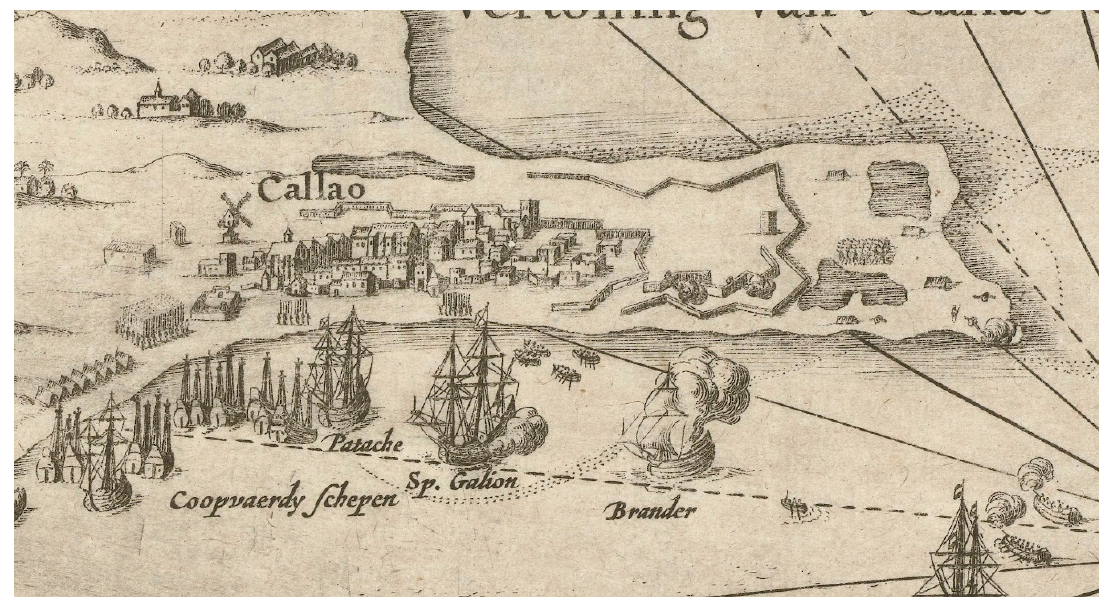
Figure 5. Callao in a 1624. Detail of view by an unknown author published in ca. 1663 [26]. Courtesy: Rijksmuseum, Amsterdam.